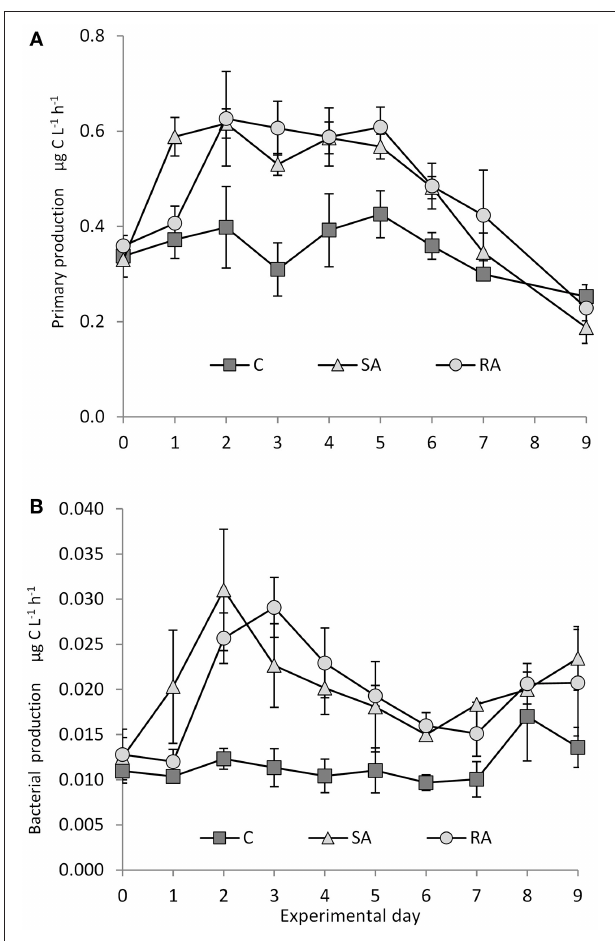
FIGURE 4 | (A) Primary and (B) bacterial production during the mesocosm experiment. Cnt = Control mesocosms (no addition), SA = single addition, mesocosms where dust was added once, on the first day of the experiment, RA = repetitive addition, mesocosms where the same quantity of dust was added, divided into three doses, on the first 3 days of the experiment, Days 0, 1, and 2. Data are mean ± SD of 3 replicates. (A) is from Lagaria et al. (2017), this SI,